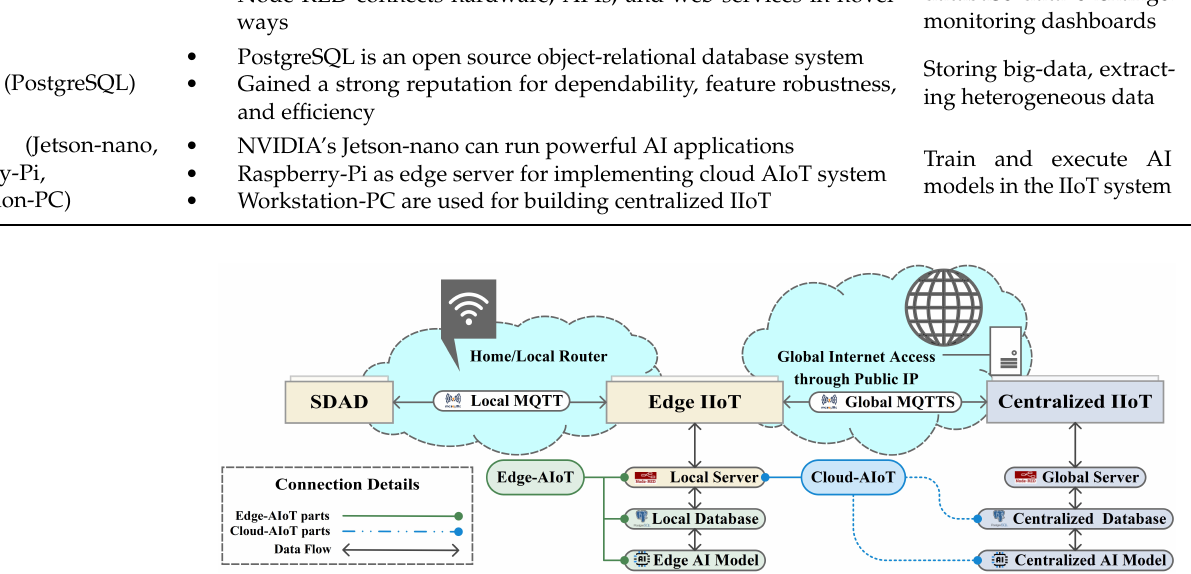
Figure 2. Proposed IIoT infrastructure.